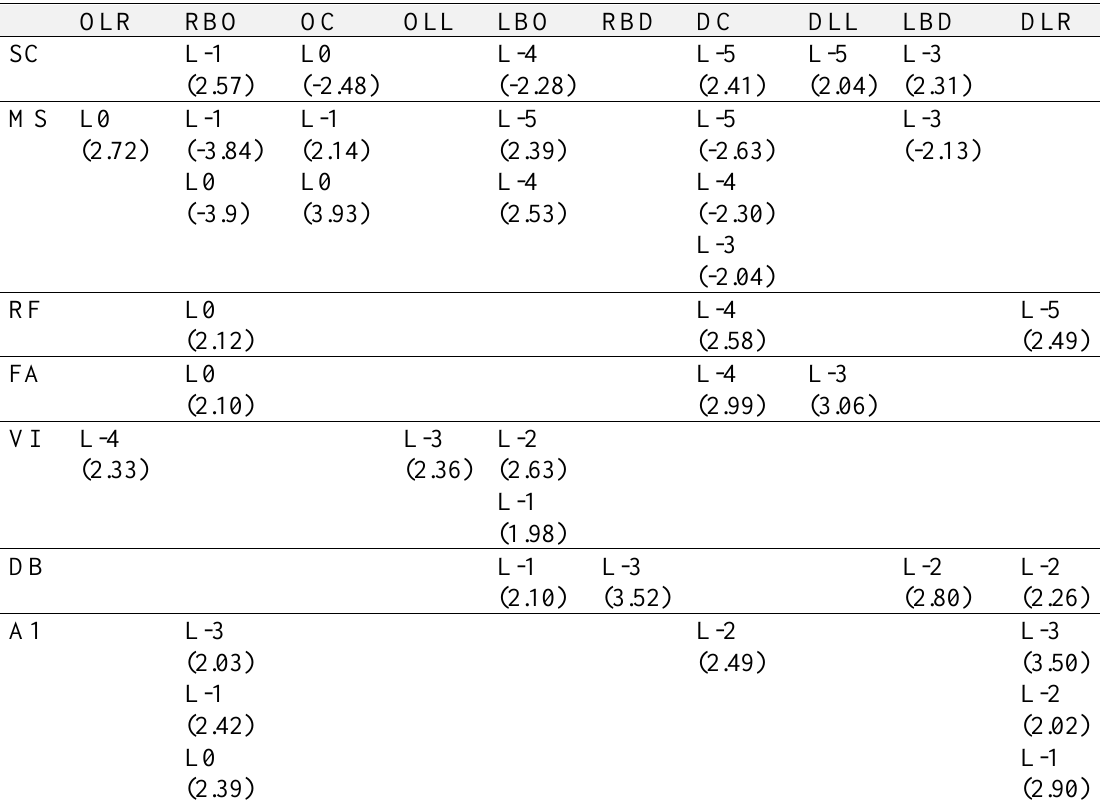
Table 2. Lag sequential analysis between the given categories of the Consequence of completion dimension and the target behaviours corresponding to the Laterality dimension.